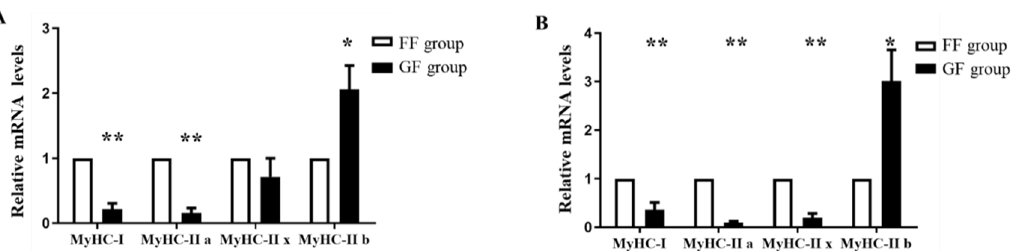
Figure 1. The expression of myosin heavy chain (MyHC) isoforms in the longissimus thoracis et lumborum (LTL) and psoas major muscle (PMM) of Heigai pigs. ( A ) Relative mRNA expression levels of MyHC isoforms in LTL. ( B ) Relative mRNA expression levels of MyHC isoforms in PMM. Each column represents the means ± SEM ( n = 5). * p < 0.05; ** p < 0.01. Table 4. Activities of muscle metabolic enzymes in the longissimus thoracis et lumborum (LTL) and psoas major muscle (PMM) under different rearing conditions in Heigai pigs.